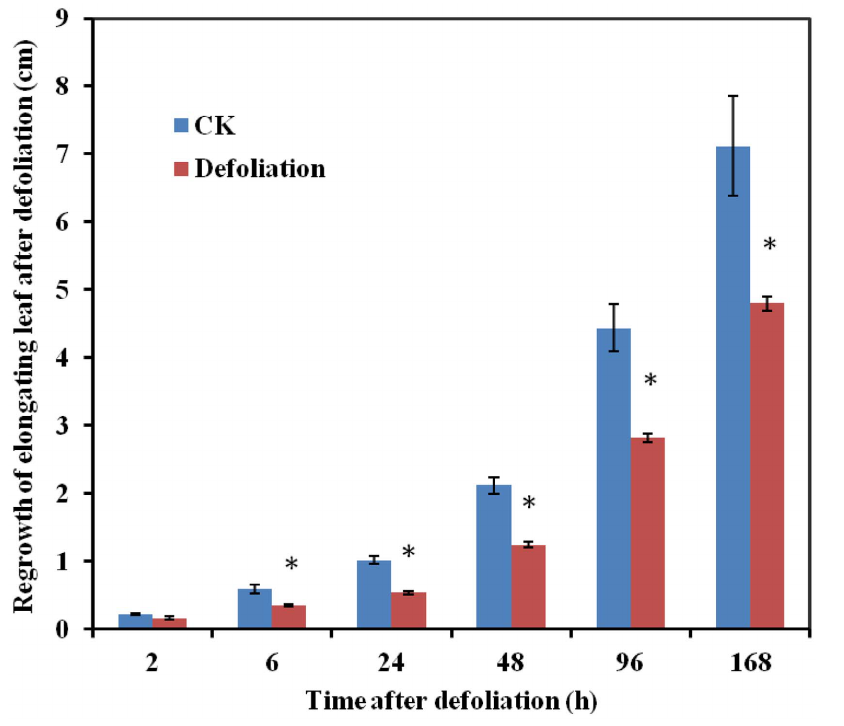
Figure 6. Impact of defoliation on regrowth of elongating leaves above the cutting level. After 8 weeks of growth, sheepgrass plants were defoliated to a stubble height of 5 cm, and regrowth of elongating leaves was measured above the cutting level after defoliation at different time points.